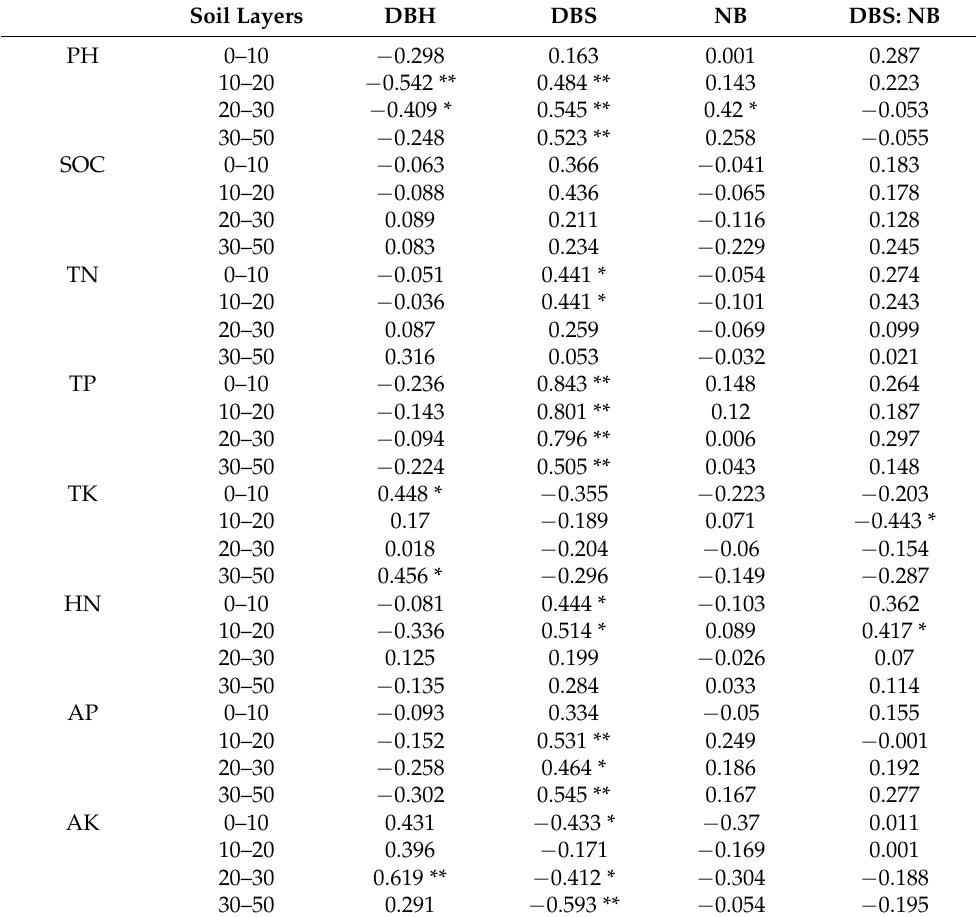
Table 3. Correlations between stand characteristics and soil nutrients in moso bamboo. Soil